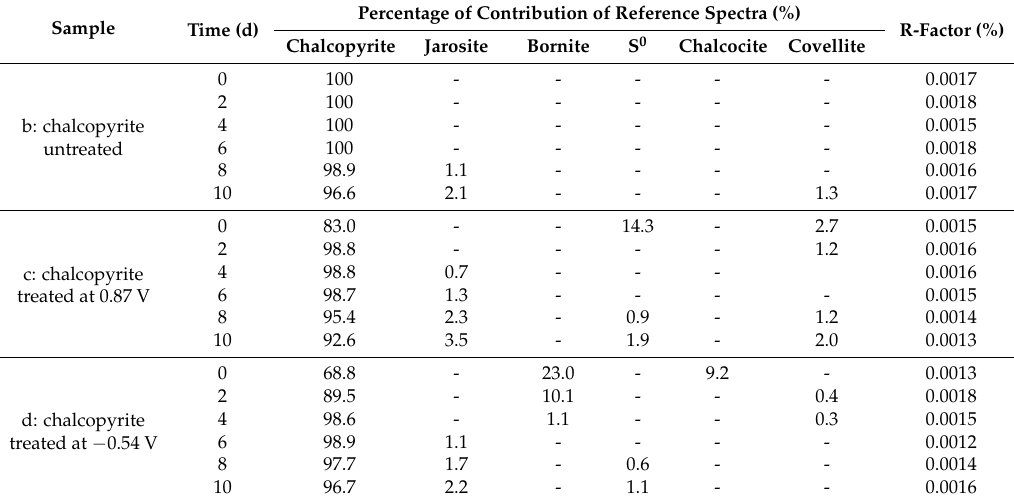
Figure 9. The sulfur K-edge X-ray absorption near-edge structure (S K-edge XANES) of chalcopyrite surfaces with leaching time, where ( A ) standards; ( B ) untreated chalcopyrite; ( C ) chalcopyrite treated at 0.87 V; ( D ) chalcopyrite treated at − 0.54 V. Table 3. The fitted S-K XANES results for Figure